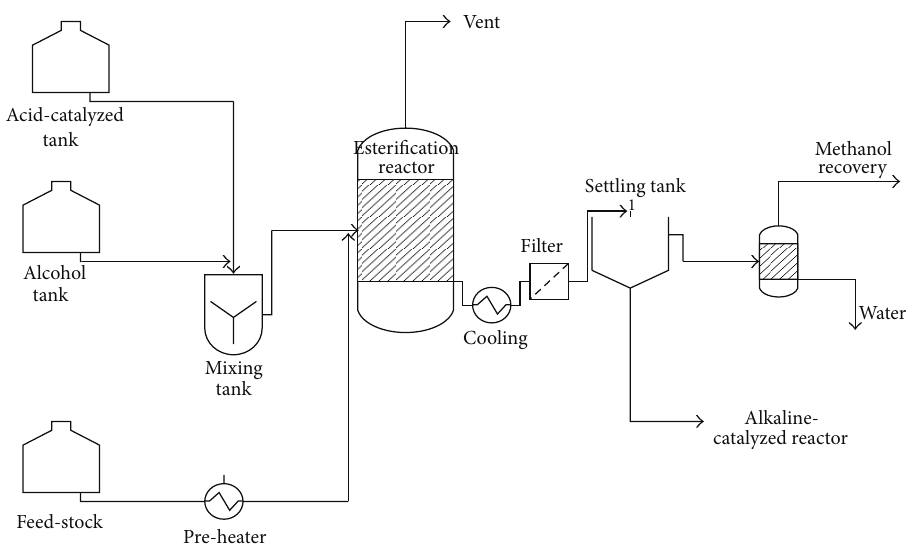
Figure 4: Pretreatment of high free fatty acid feed-stock with acid-catalyzed reactor—process I [70,